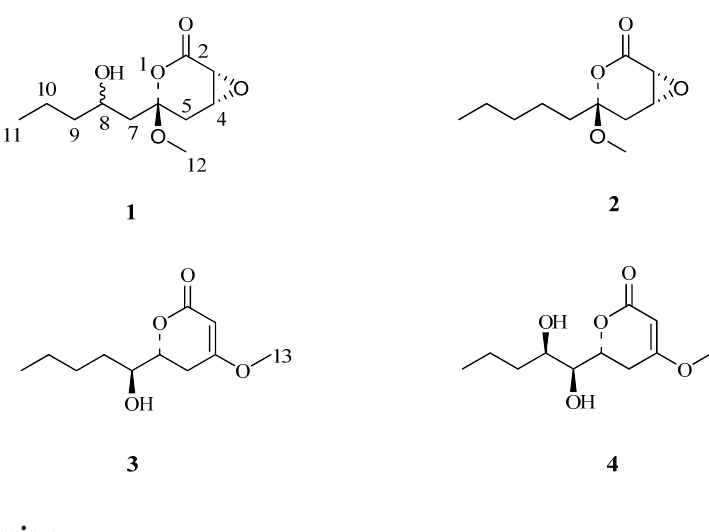
Figure 1. The structures of compounds 1 – 4